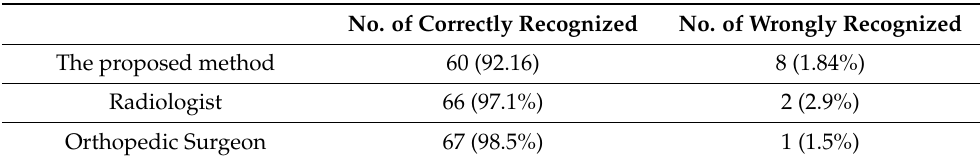
Table 2. The accuracy rate of clinical CS X-ray image